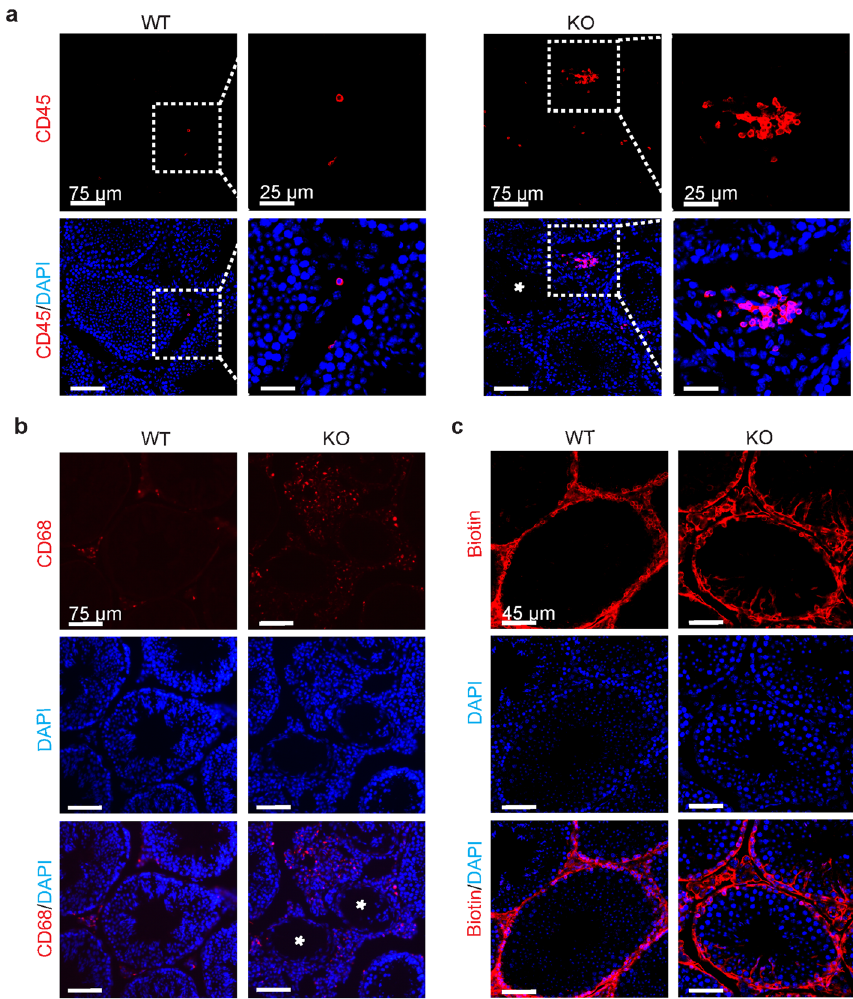
Fig. 2 Comparison of the integrity of the blood–testis barrier between WT and Alkbh5 ‑deficient mice. a , b Immunofluorescence analysis showing CD45 + ( a ) and CD68 + ( b ) cells infiltrated into the stroma in the testis of wild‑type (WT) ( n 3) and Alkbh5 ‑deficient (KO) ( n 3) mice, respectively (asterisk indicates = = morphologically damaged seminiferous tubule). c BTB assay detecting the integrity of the blood–testis barrier in WT ( n 3) and Alkbh5 ‑KO mice ( n = =